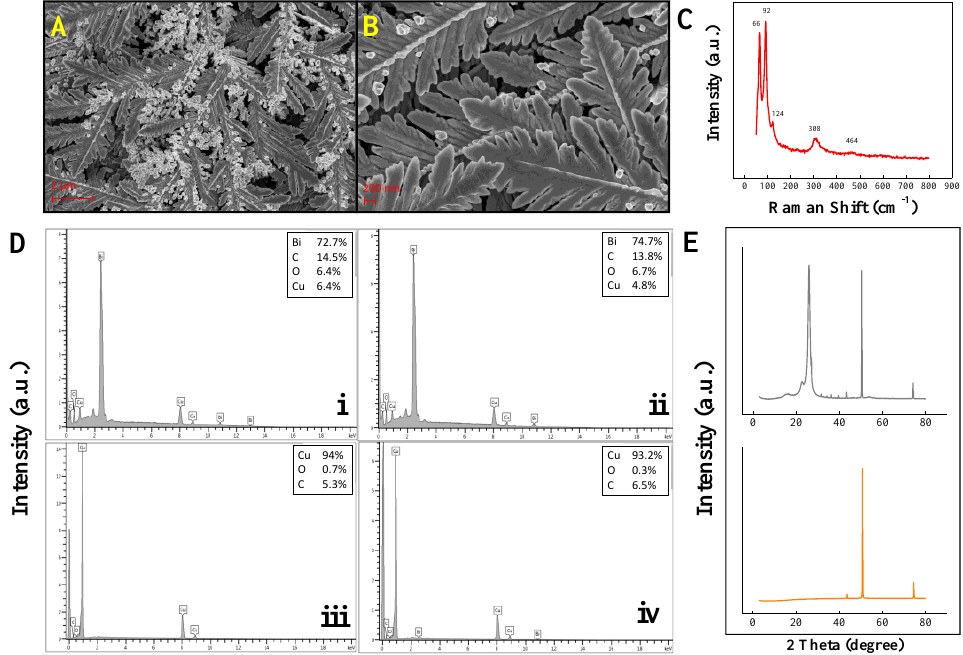
Figure 2. SEM–FEG image for flexible copper sensor decorated with bismuth micro/nanodentrites under different magnifications of 20,000 × in ( A ) and 50,000 × in ( B ). Raman spectra of flexible copper sensor decorated with bismuth micro/nanodentrites in ( C ). Energy-dispersive X-ray spectroscopy for flexible copper sensor decorated with bismuth micro/nanodentrites before ( D (i)) and after ( D (ii)) sensing, and for bare flexible copper sensor before ( D (iii)) and after ( D (iv)) sensing. XRD patterns of flexible copper sensor decorated with bismuth micro/nanodentrites (top, in gray) and bare flexible copper sensor (bottom, in orange) in ( E ).